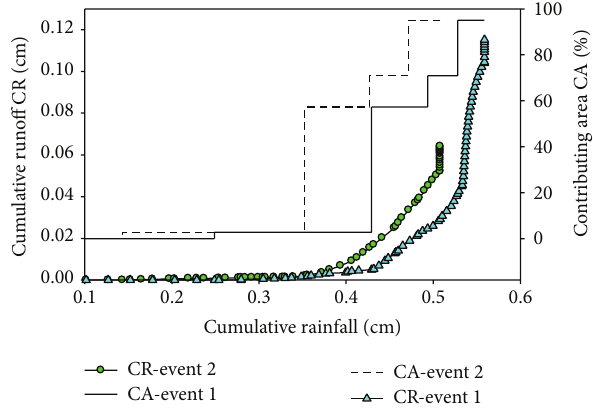
Figure 9: Relationships of cumulative rainfall and cumulative runoff (CR) and contributing area (CA) for the rough field plot surface under two natural rainfall events (Event 1: short-duration heavy rainfall on June 26, 2011; Event 2: long-duration light rainfall on August 12,